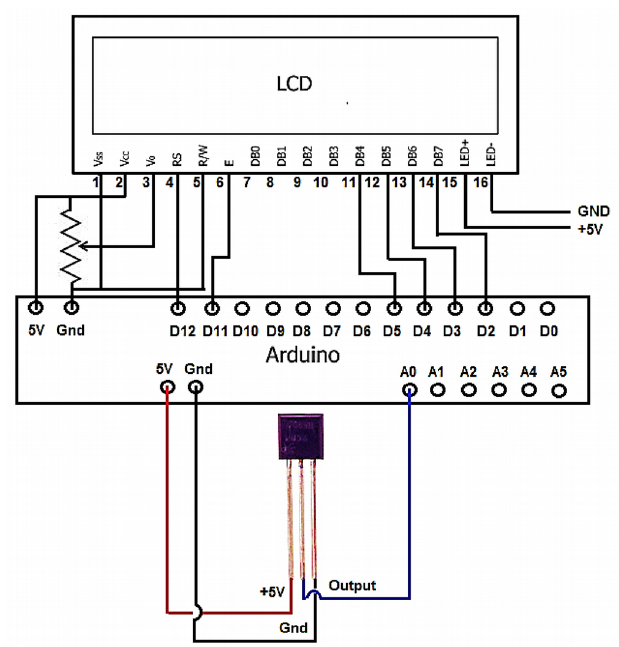
Figure 5. The schematic circuit to construct the hands-on digital